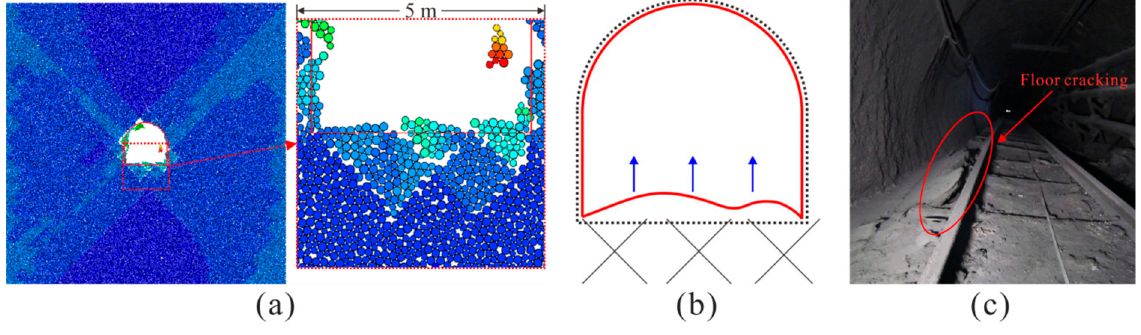
Figure 17. Schematic diagram of partial floor heave. ( a ) Numerical simulation result; ( b ) Failure mechanism; ( c ) Field representation.